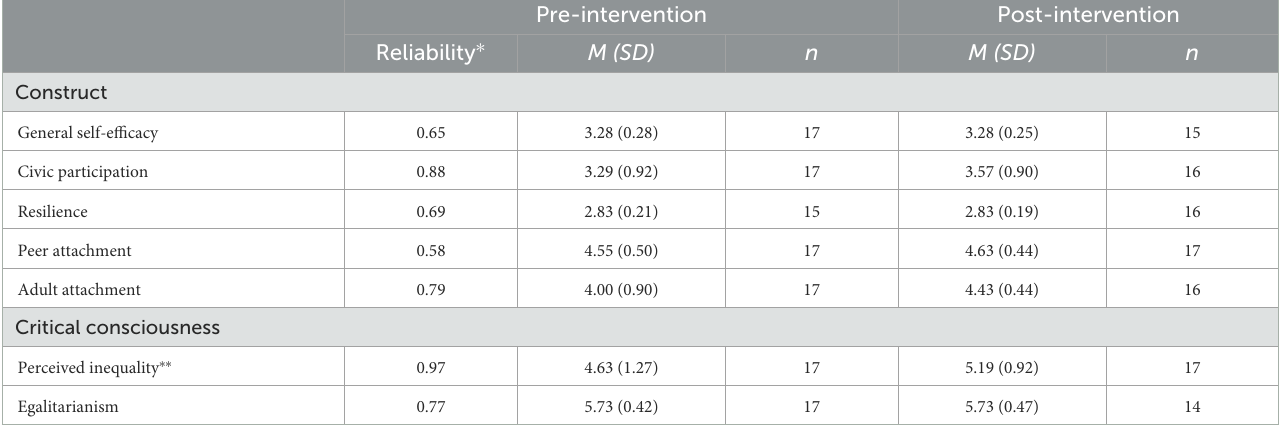
TABLE 4 Constructs of youth participants’ positive mental health pre- and post-intervention. Pre-intervention